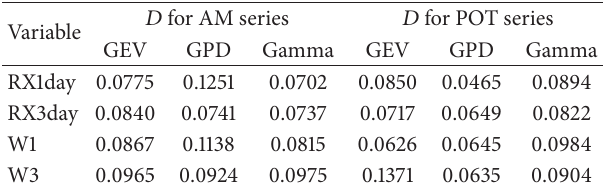
Table 2: The KS test statistic 𝐷 value of marginal distribution